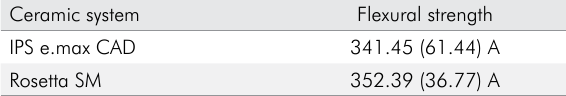
Table 2. Mean flexural strength (MPa) values (SD) for CAD-CAM lithium disilicate glass ceramic systems (MPa).